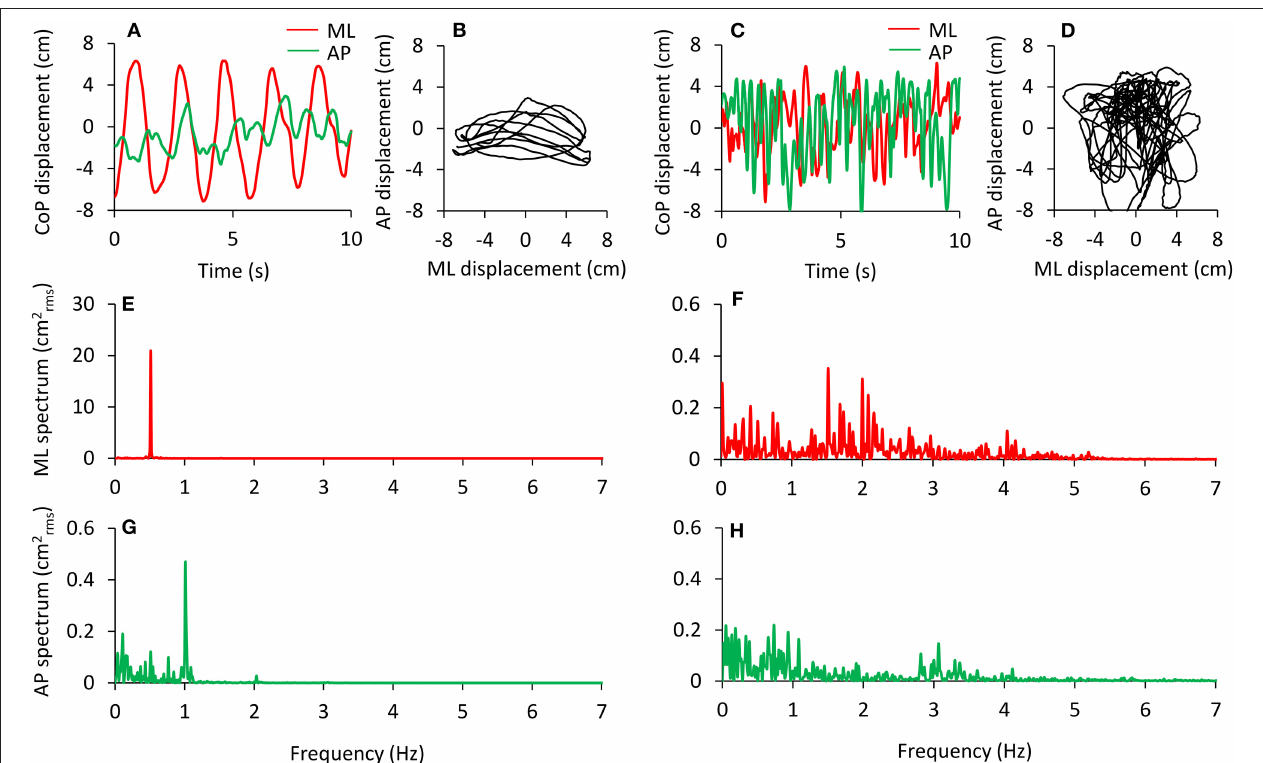
FIGURE 2 | Examples of deliberate sway of the body are performed in order to test the recording and analysis procedures. Voluntary, wide, and rhythmic predominantly mediolateral oscillations were performed in response to 0.5Hz beeps of a metronome (A,B) . The relevant power spectrum profiles in the frontal (ML, with a large peak at 0.5Hz) and sagittal (AP) planes are reported in (E,G) . Note the difference in the ordinates of (E,G) . The same subject deliberately performed large body movements at the highest frequency possible (C,D) . The relevant power spectrum profiles are shown in (F,H) . Now the oscillation frequencies have a wider range and smaller peak amplitudes. Under both circumstances, the deliberate oscillations were performed with the eyes open and lasted 90s. In (A–D) , only 10s are depicted for easily identifying the CoP oscillations. The traces are dispersed around zero because their mean value has been removed. The power spectra are computed over the 90s trial.